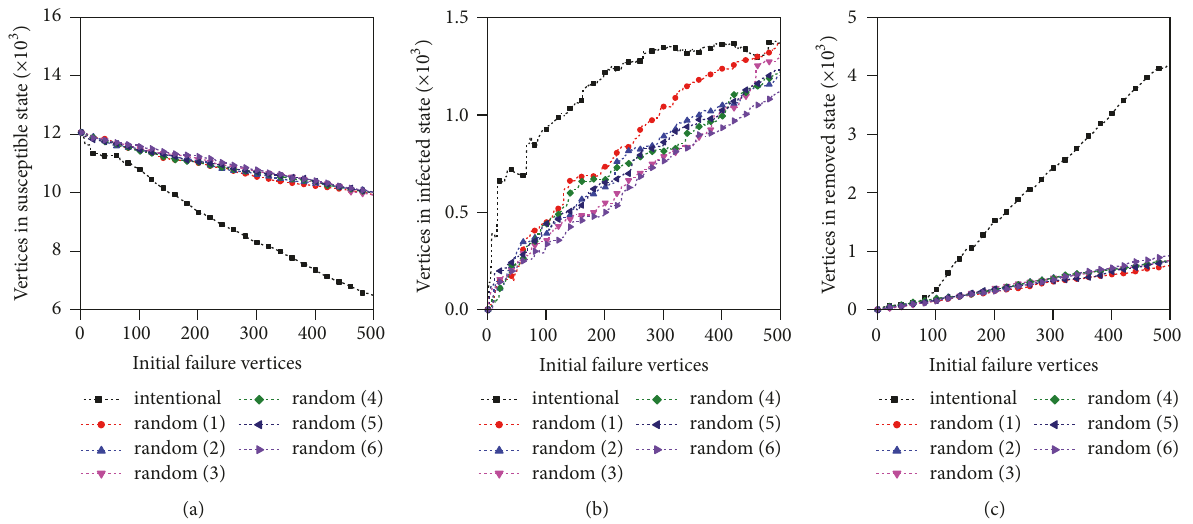
Figure 10: Crisis spreading when networks meet random failure and intentional attack (nonlisted shareholders).